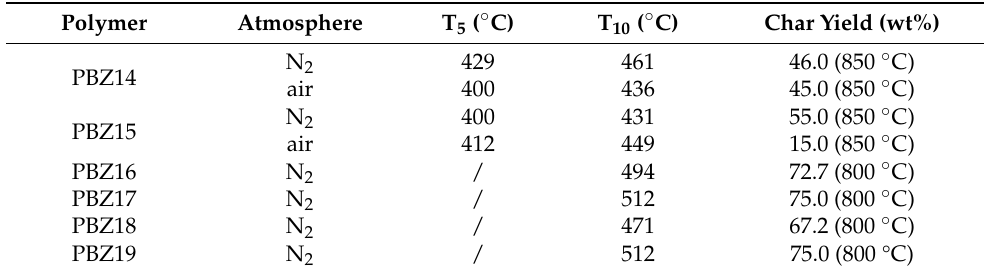
Table 4. Thermal properties of polybenzoxazines derived from BZ14–BZ19